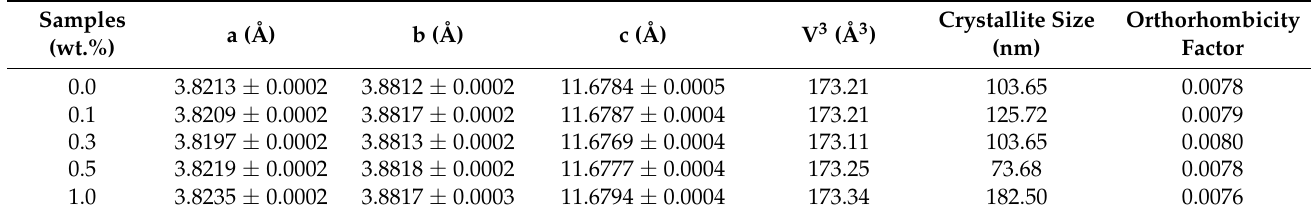
Table 1. Lattice parameters of a, b and c axes, unit cell volume, crystallite size and orthorhombicity of Y123 + x wt.% graphene nanoparticles.